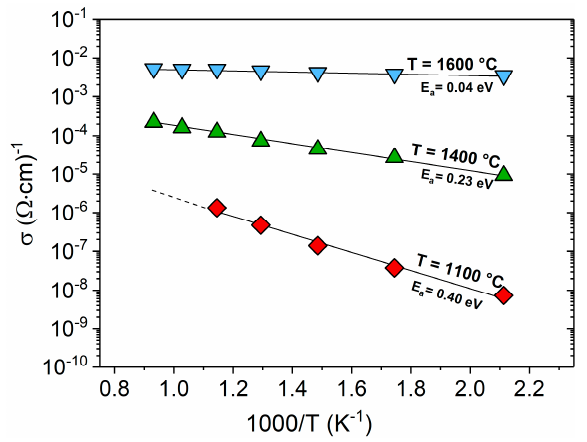
Figure 7. Electrical conductivity of C-11 as a function of the inverse of the treatment temperature.